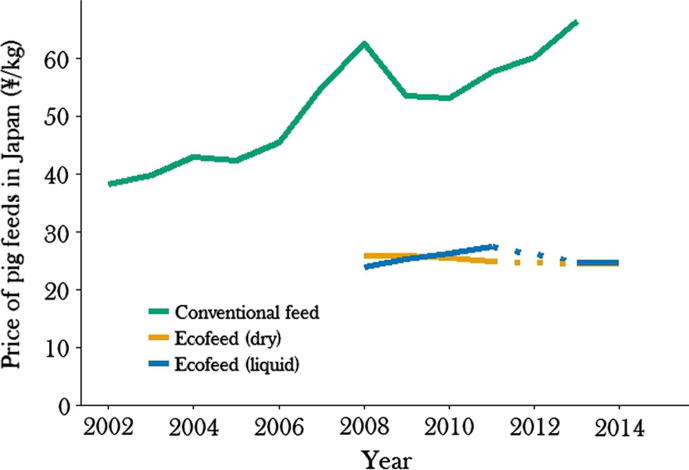
Prices of conventional pig feed and swill (Ecofeed) in Japan. Dry Ecofeed is fed as a dehydrated pellet, liquid Ecofeed is fed as a wet feed. Dotted lines are an interpolation between the 2011 and 2013 values. Data from: (MAFF, 2014, MAFF, 2013, MAFF, 2012b, MAFF, 2011, MAFF, 2010, MAFF, 2009).